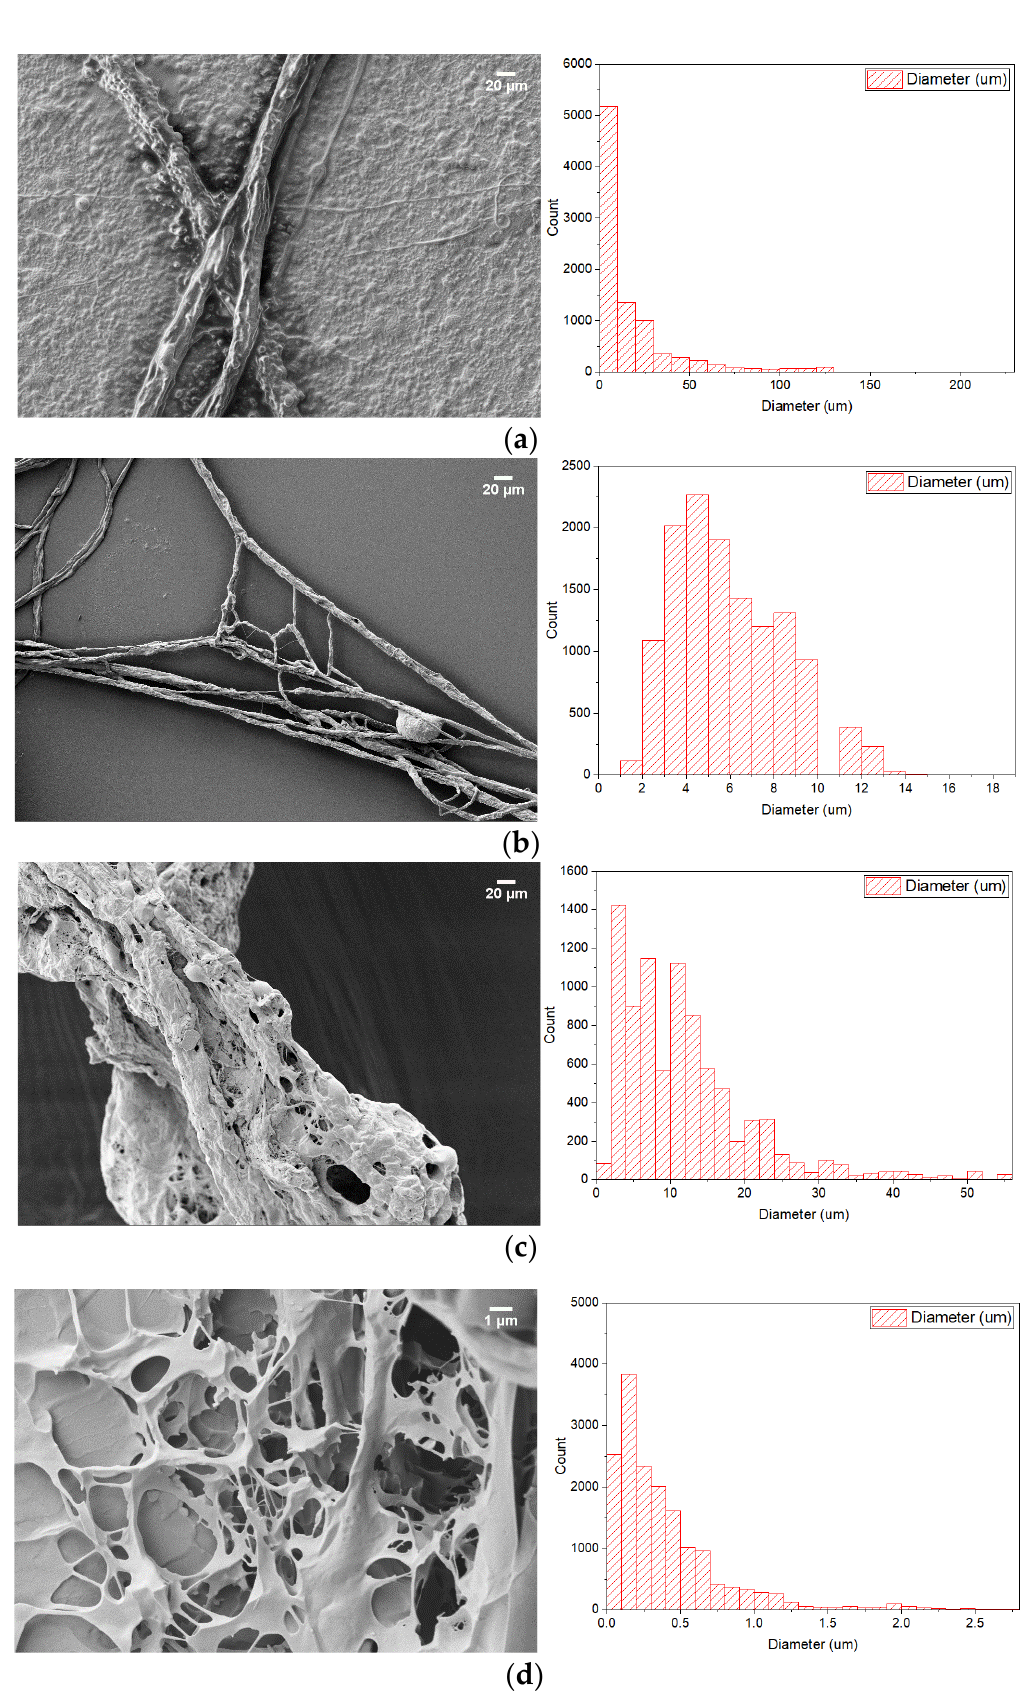
Figure 6. SEM figures of a) PT15 9%PCL 0.3-0.6ml/h, b) PT18 9%PCL 0.3-0.6ml/h, c) RT15 9%PCL 0.3-0.6ml/h, d) RT18 9%PCL 0.3- 200